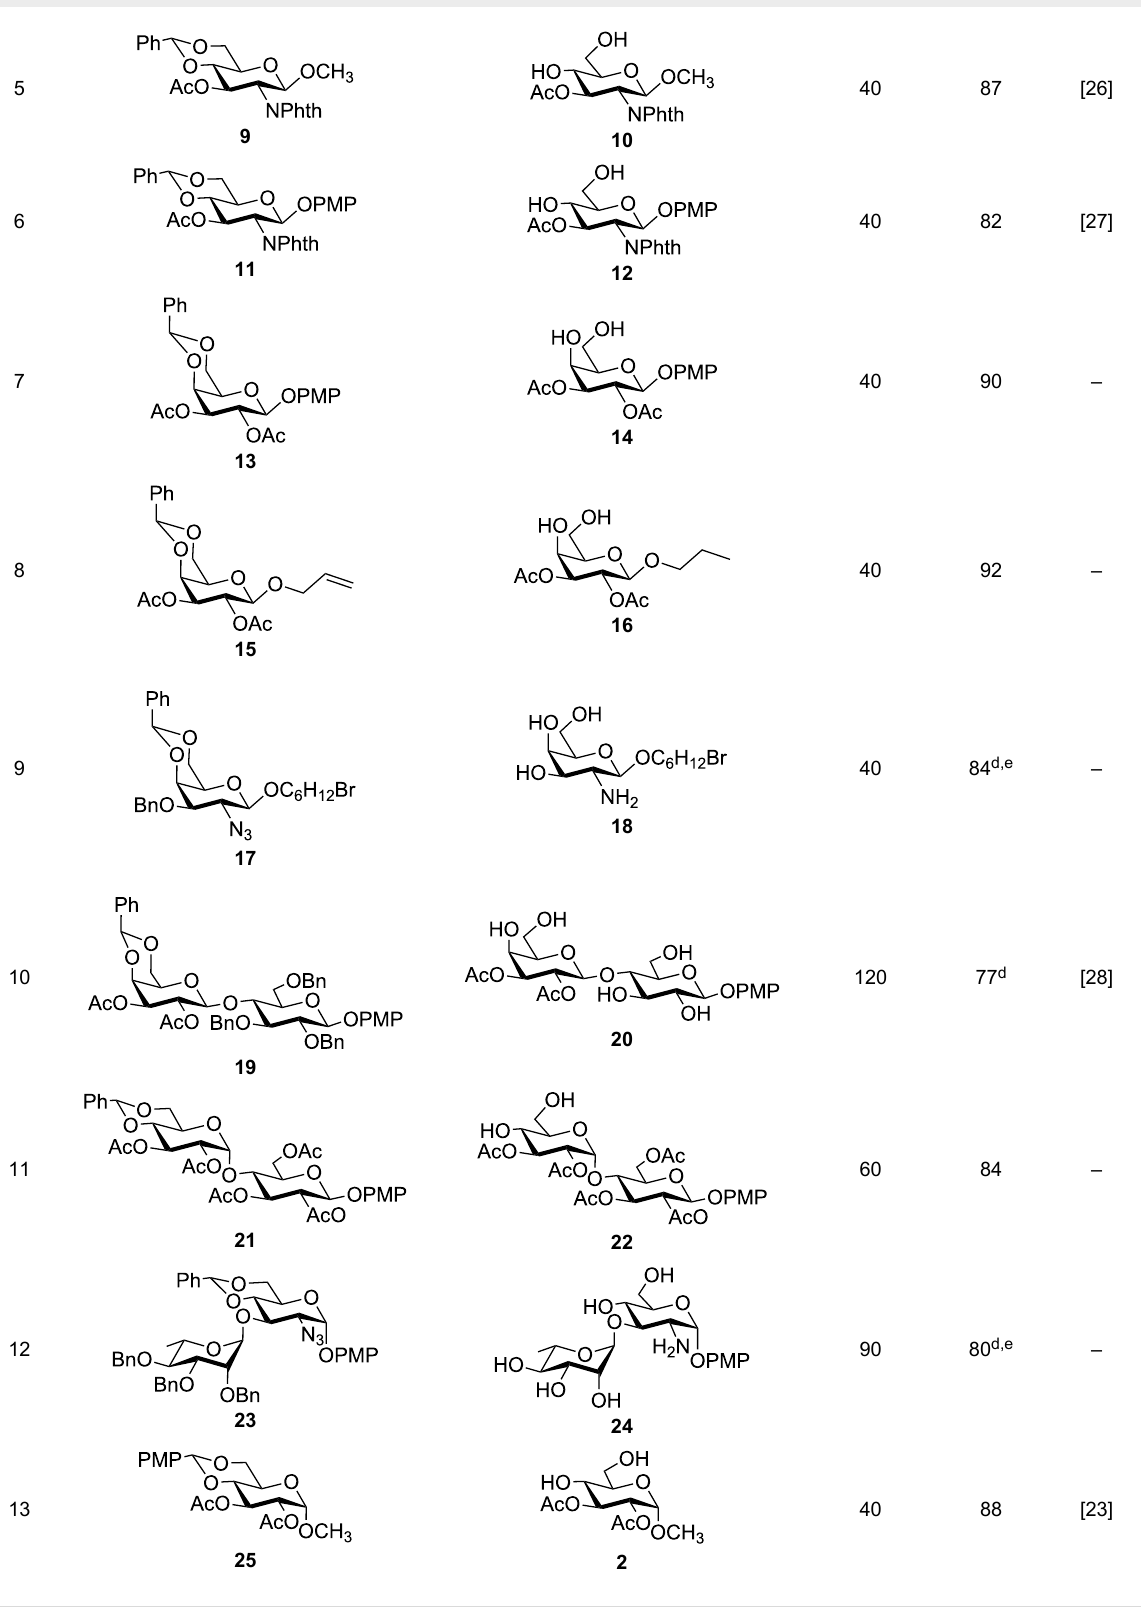
Table 1: Conversions of carbohydrate derivatives effected with Et 3 SiH and 10% Pd/C.